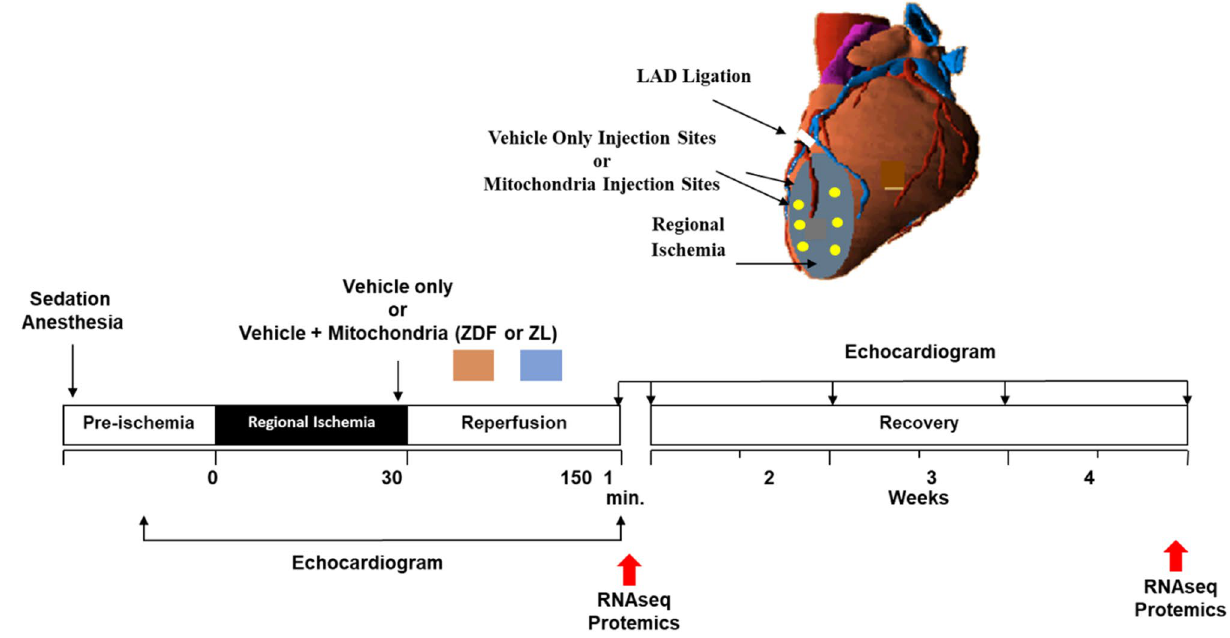
Figure 1. Experimental Model: ZDF rats (male, 14 weeks) were sedated and intubated. A left lateral thoracotomy was performed, and the heart was exposed. Regional ischemia was achieved by temporarily snaring the LAD. Following 30 min of ischemia, the snare was released, and 6 × 50 uL injections of vehicle solution alone (Vehicle) or vehicle solution containing mitochondria (1 × 10 6 ) isolated from either diabetic ZDF rat pectoralis major (diabetic ZDF-mitochondria) or mitochondria (1 × 10 6 ) isolated from non-diabetic Zucker lean rats (non-diabetic ZL-mitochondria) were delivered by epicardial injection into six pre-selected sites in the area-at risk, using a 1 mL tuberculin syringe with a 32-G needle. The ZDF rats were allowed to recover for 2 h or 28 days.